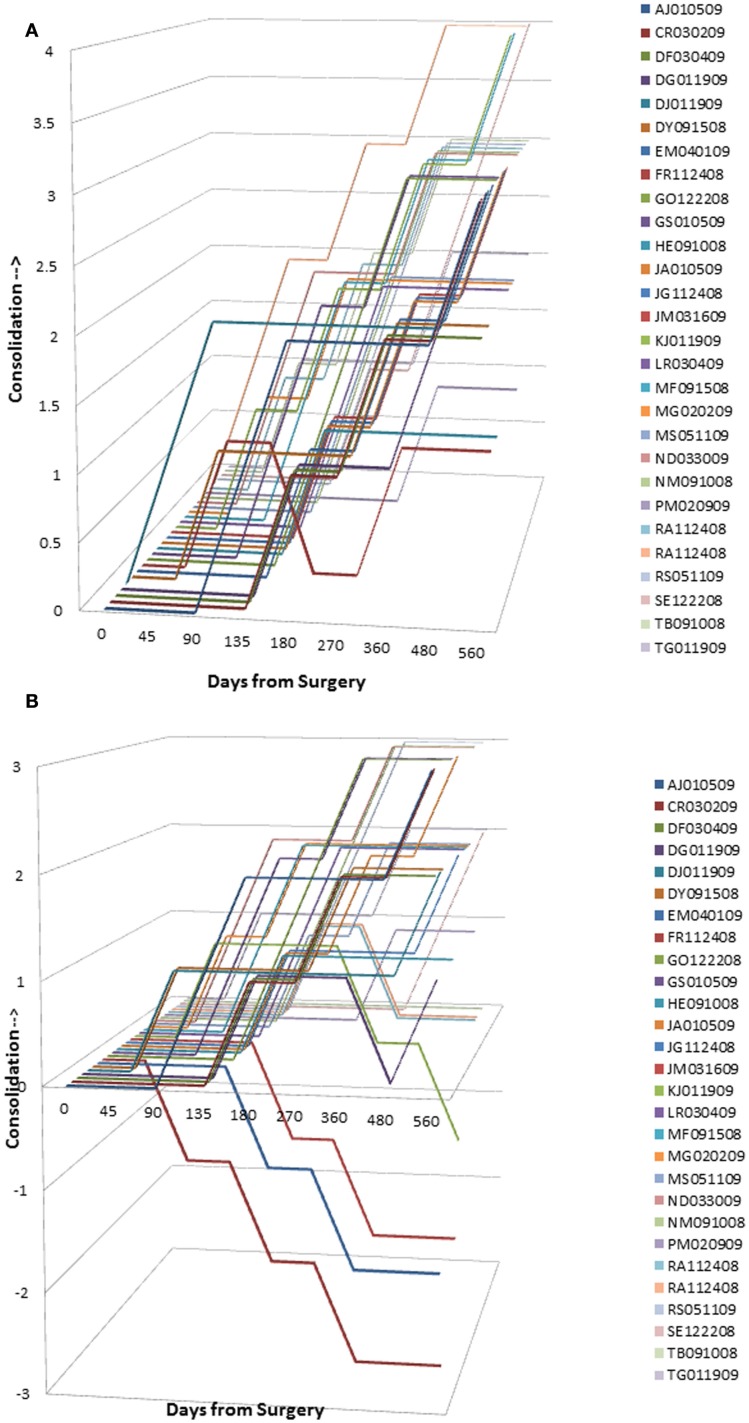
(A) InQu resorption/consolidation assessment by subject over time. Each line lies in the upper half of the graph demonstrating that there is no significant initial resorptive phase, only intervals of increasing consolidation over time. (B) β-TCP resorption/consolidation assessment by subject over time. A flat line demonstrates for most of the β-TCP-treated fusion segments between days 91–135 no change in radiographic appearance from surgery. Once the mineral content has been cleared, an increase in the height of the plotted lines (consolidation) was observed for one or more time intervals in 21 of 28 fusion segments. However, from day 135 and on, 7 of 28 fusion segments (25%) showed a steady decline in line height toward the negative portion of the graph, indicating that more resorption had occurred than consolidation.